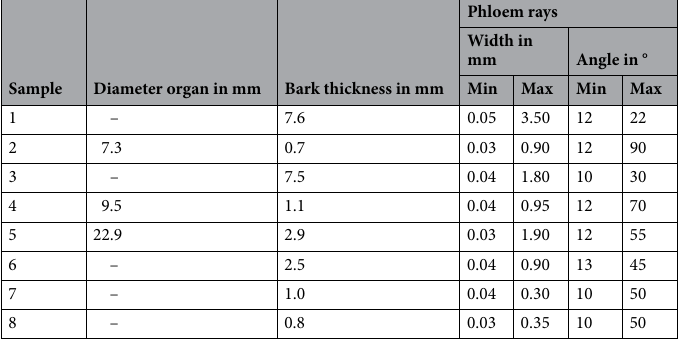
Table 3. Measurements of anatomical features extracted from µCT